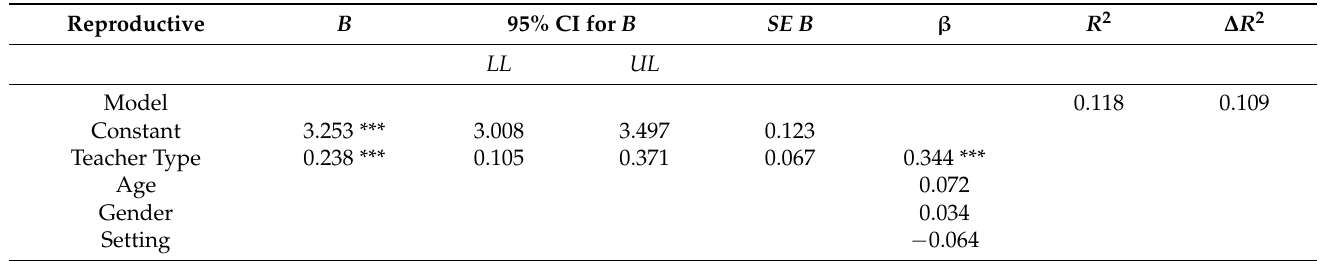
Table 2. Multiple regression results for reproductive cluster (preservice, generalist, and specialist teachers).